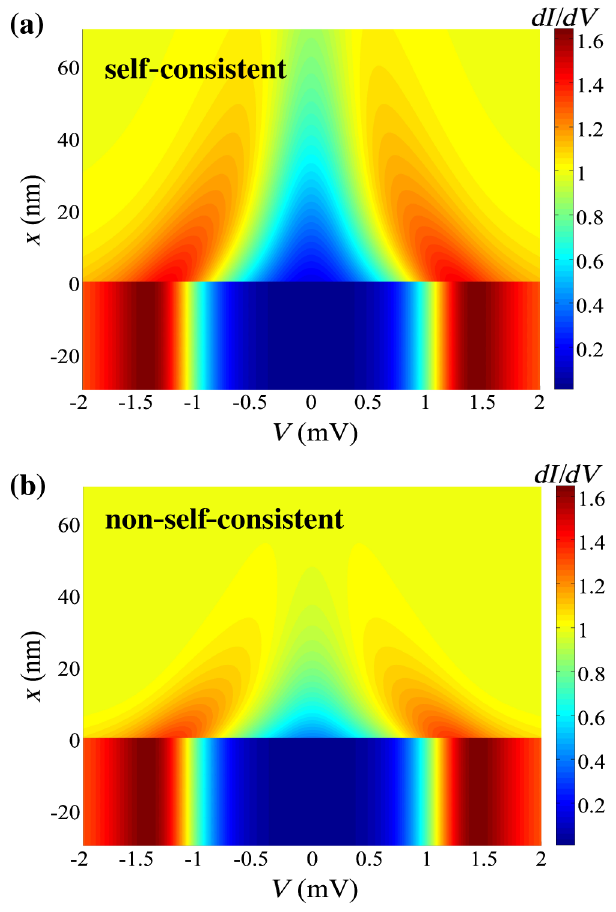
FIG. 12. Computed normalized tunneling spectra as a function of the bias and the position measured with respect to the island edge. (a) Results obtained in a self-consistent calculation using the following parameter values: T ¼ 2 . 05 K, Δ 1 ¼ 1 . 2 meV, Δ as in panel (a) but for a non-self-consistent calculation where the order parameter is assumed to vanish in the